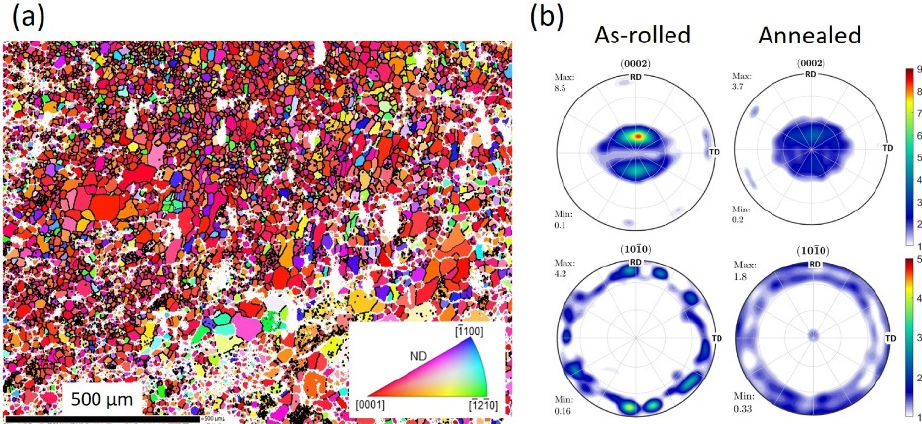
Figure 3. ( a ) Inverse pole figure (IPF) EBSD map with respect to the sheet normal direction (ND) of the annealed LX41 specimen depicting a broad spectrum of crystal orientations, ( b ) XRD textures of the as ‐ rolled and annealed LX41 alloy represented by means of basal and prismatic pole figures. The texture intensity is given in terms of multiples of a random distribution (mrd). The pole figures reveal a significant weakening of the RD ‐ split basal texture evident after rolling deformation.